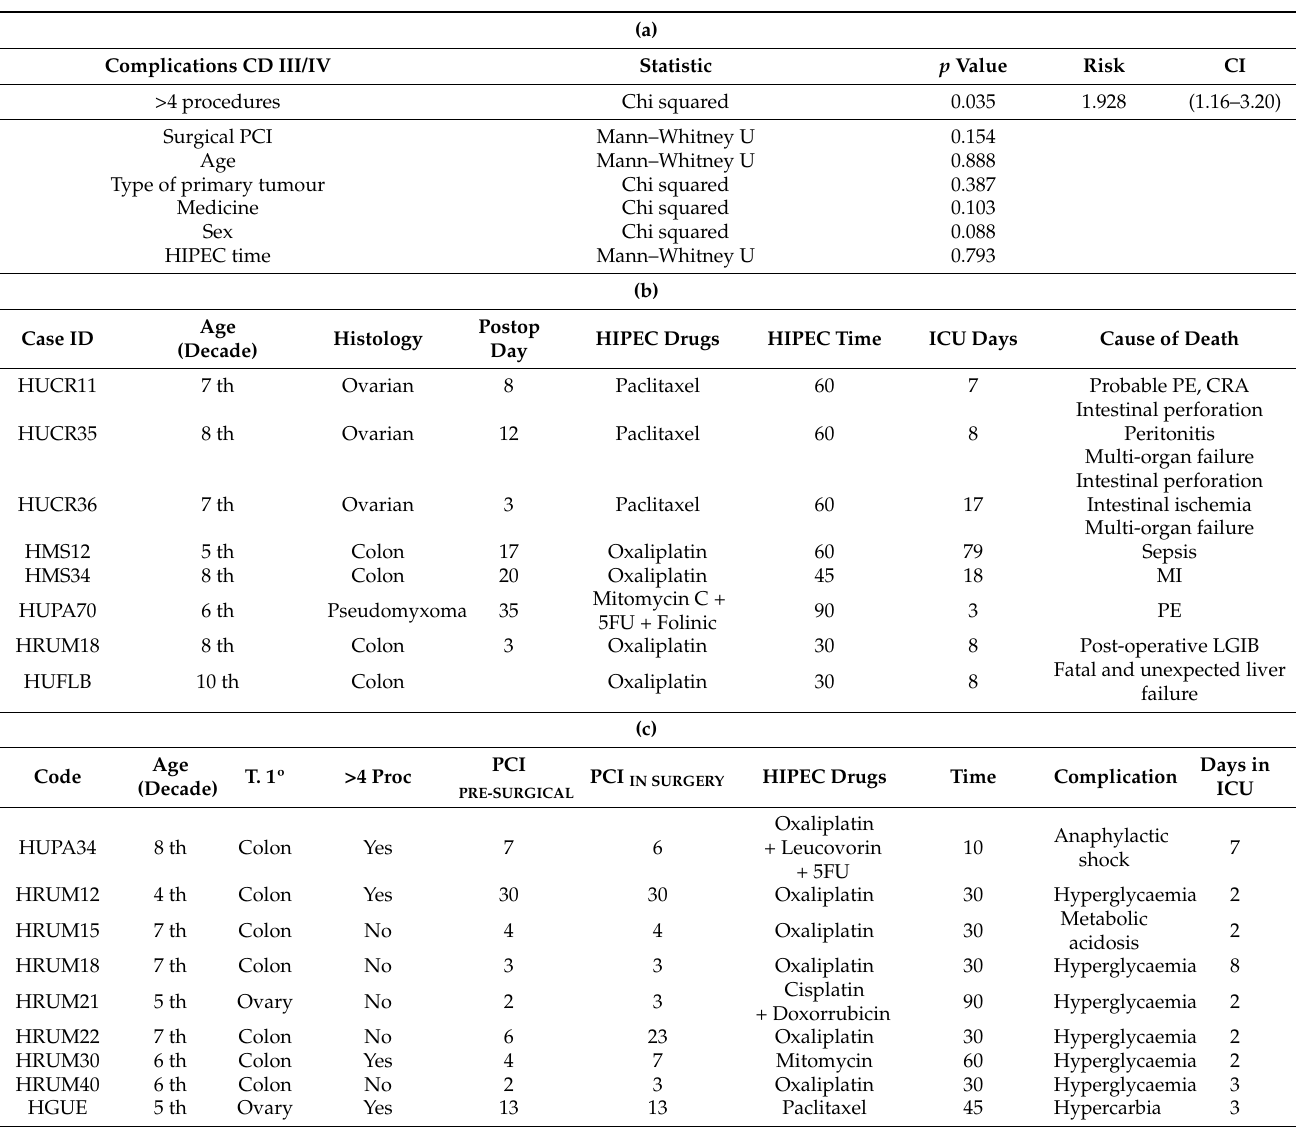
Table 5. Part (a) Relation between variables and increased morbidity; Part (b) Postoperative deaths (Clavien-Dindo V) (Decade 1 = 0–9 years; decade 2 = 10–19 years, and so on); Part (c) HIPEC specifically-related complications (CD